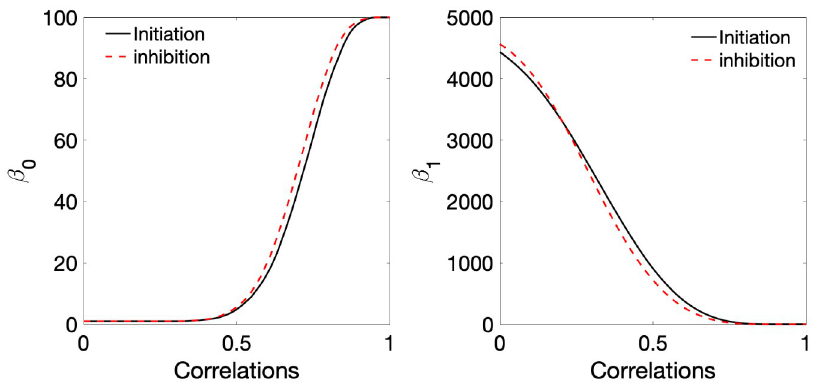
Fig 10. The average Betti curves of obtained from the graph filtration on correlation matrices computed separately for the inhibition (go) and initiation (no-go) blocks of fMRI time series in cognitive aging study [130,